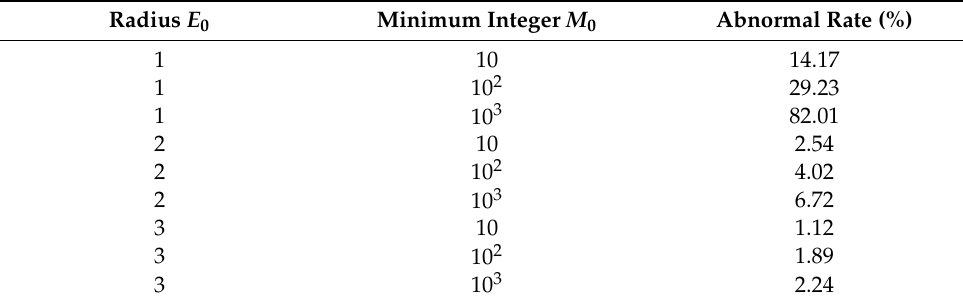
Table 4. The abnormal rate for different radii and minimum integers.